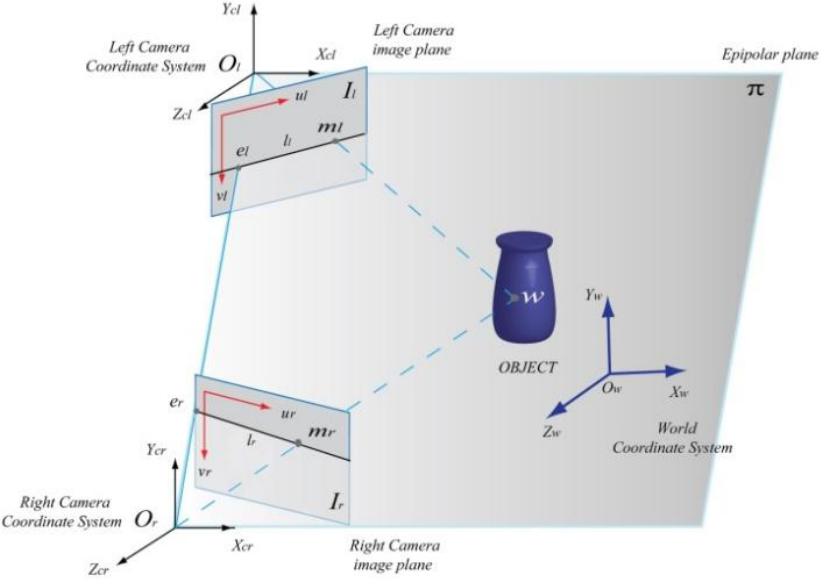
Figure 2. Epipolar geometry. The points m and m , located in left and right images, l r respectively, are the projection on the image planes I and I of the same 3D point w of the l r object. The intersections of the line (O , O ) (baseline) with each image plane are called l r epipoles (e and e ). The lines l and l are called epipolar lines, intersection of the epipolar l r l r plane p (O , O , w) with the two image l r